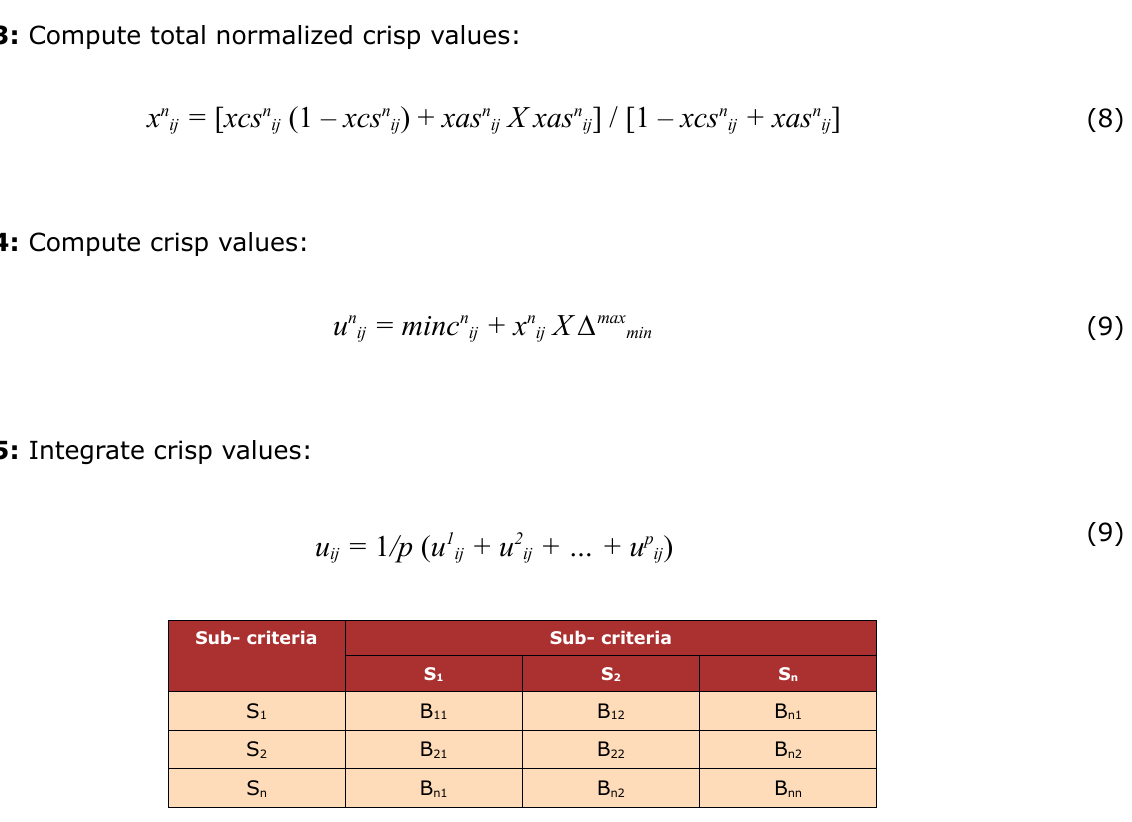
Table 2. Direct- relation